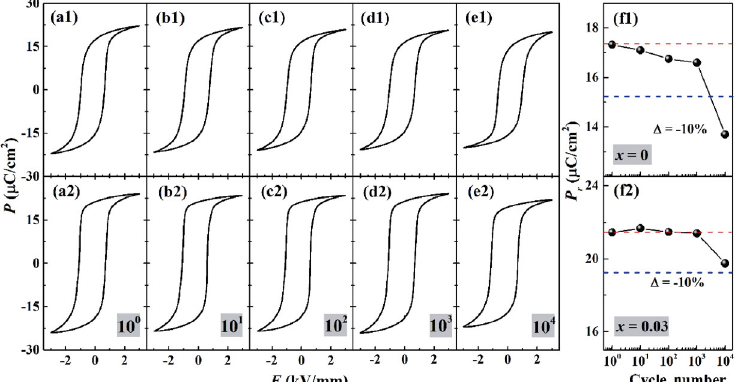
Fig. 10 P – E hysteresis loops measured after 10 0 , 10 1 , 10 2 , 10 3 , and 10 4 fatigue cycles of (a1–e1) x = 0 and (a2–e2) x = 0.03 ceramics. P r as a function of fatigue cycle for (f1) x = 0 and (f2) x = 0.03 ceramics.